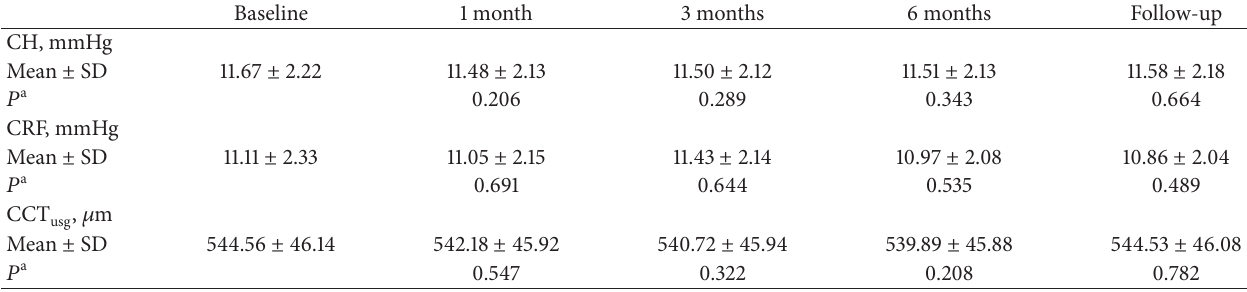
Table 3: Biomechanical parameters measured with ocular response analyzer and central corneal thickness measured with ultrasonic pachymeter before and after